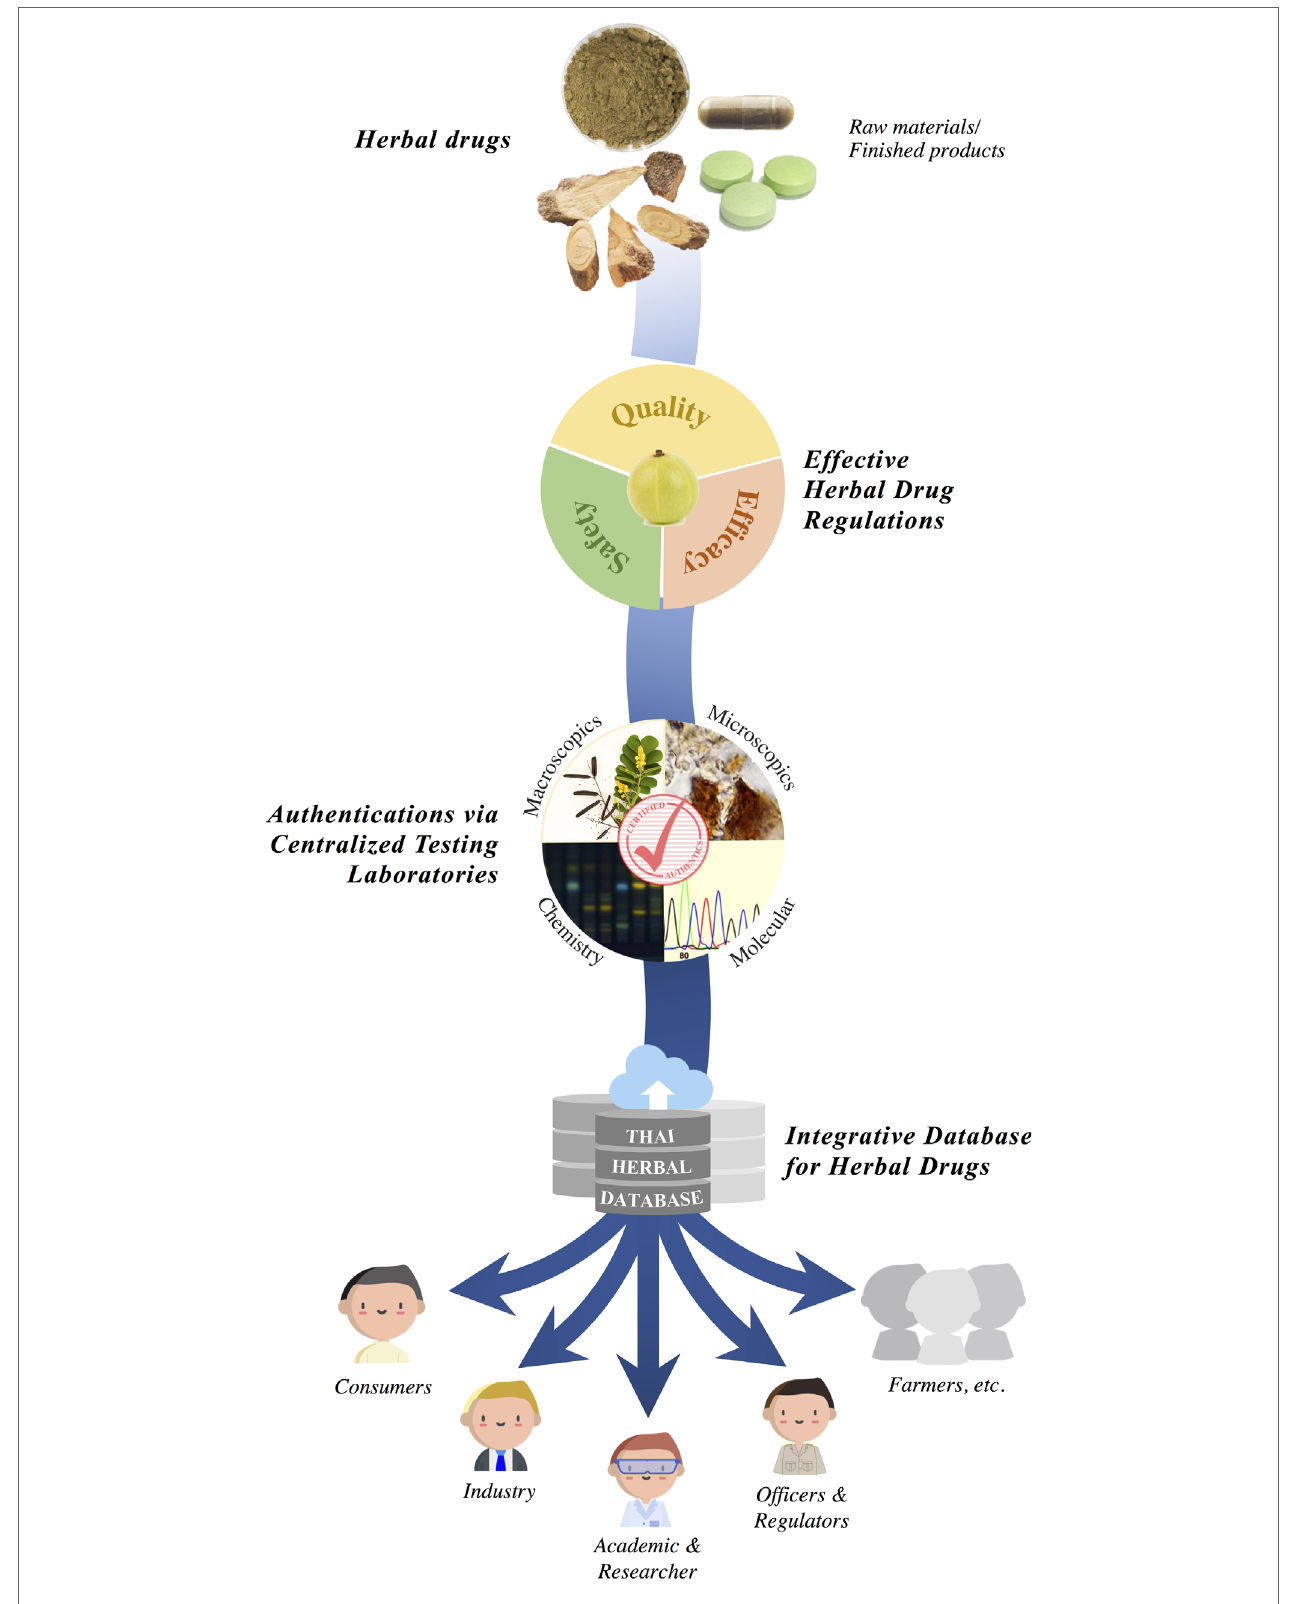
FIGURe 1 | Proposed regulatory framework of traded herbal drugs of Thailand.